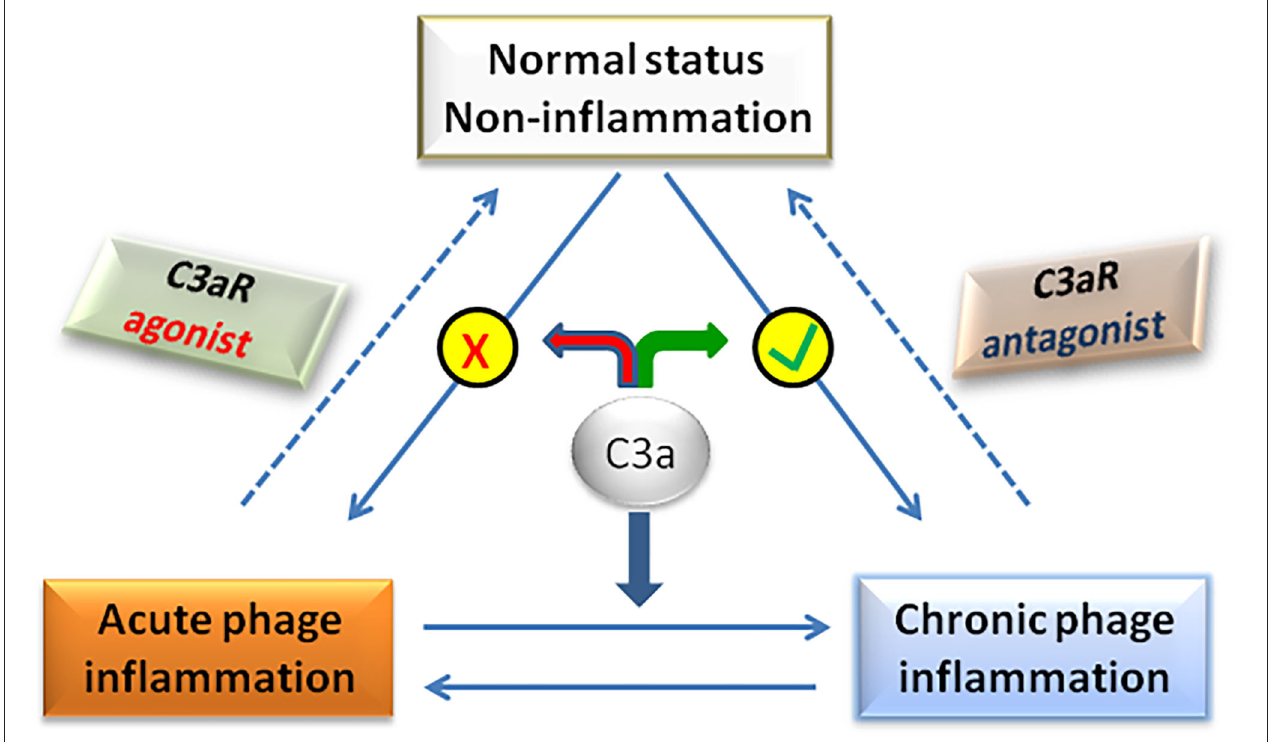
FIGURE 3 | The balance of C3a actions determines the disease